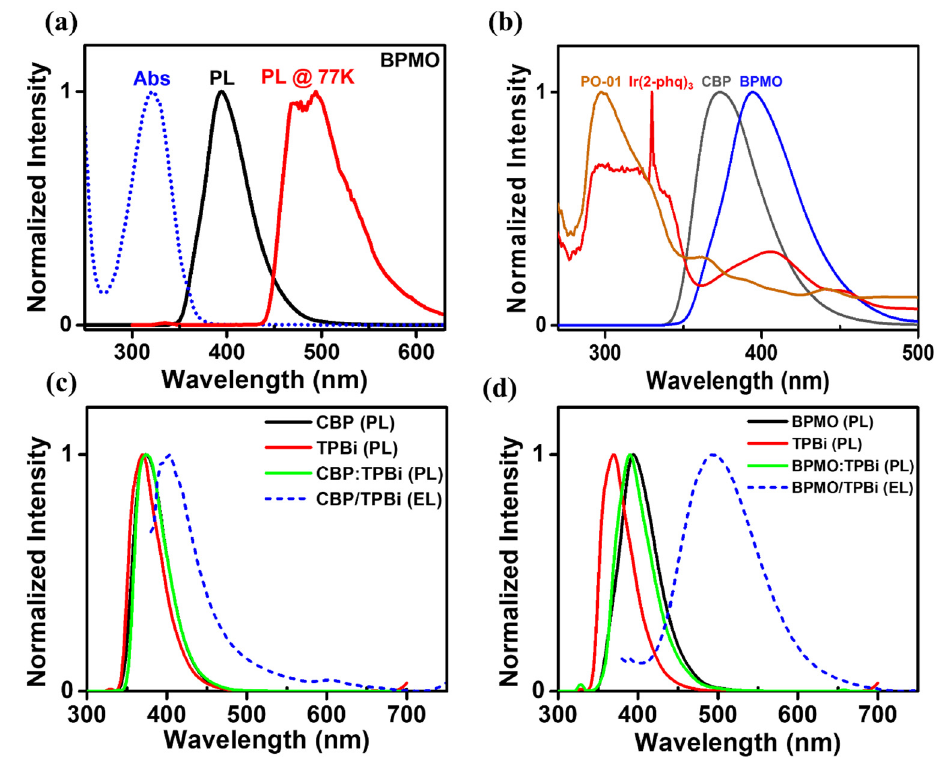
Figure 2. The photophysical and electroluminescent (EL) characteristics showing ( a ) singlet (3.44 eV) and triplet energy (2.87 eV) of the host BPMO measured using Abs/PL and PL/PL (at 77 K) spectrum, respectively. ( b ) The overlapping area between PL of hosts BPMO and CBP and Abs of yellow (PO-01) and orange-red (Ir(2-phq) 3 ) dye. BPMO shows the larger overlapping area, ( c ) and ( d ) show a larger redshift between the PL and EL spectra for host BPMO than CBP. The shifting is observed between the individual and mixture of host BPMO/CBP and electron-transporting layer (ETL) TPBi, respectively. Figure 2b shows the overlapping area between normalized PL of hosts BPMO and CBP and normalized Abs of yellow (PO-01) and orange-red (Ir(2-phq) 3 ) dye incorporated in the candlelight organic LED devices. BPMO shows the larger overlapping area with the absorbance of yellow dye (PO-01) and orange-red dye (Ir(2-phq) 3 ) as 20.37 and 31.52 square units, respectively, in lieu of host CBP (19.36 and 22.6 square